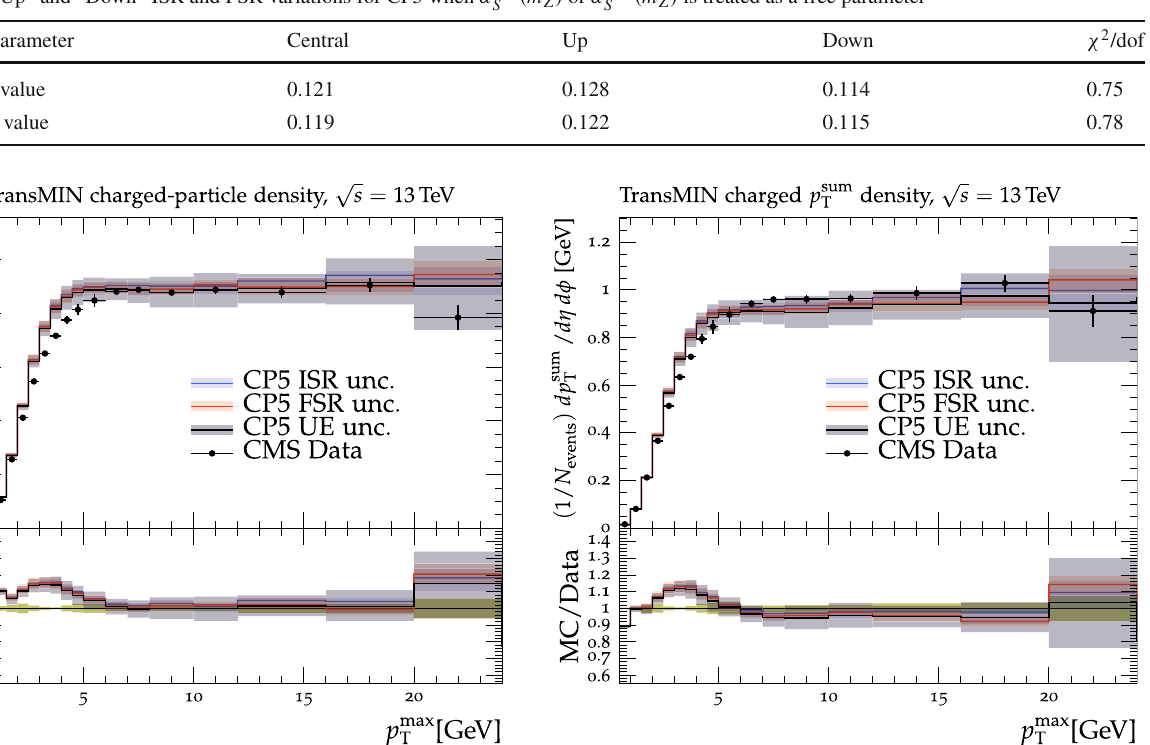
Table 9 “Up” and “Down” ISR and FSR variations for CP5 when α ISR